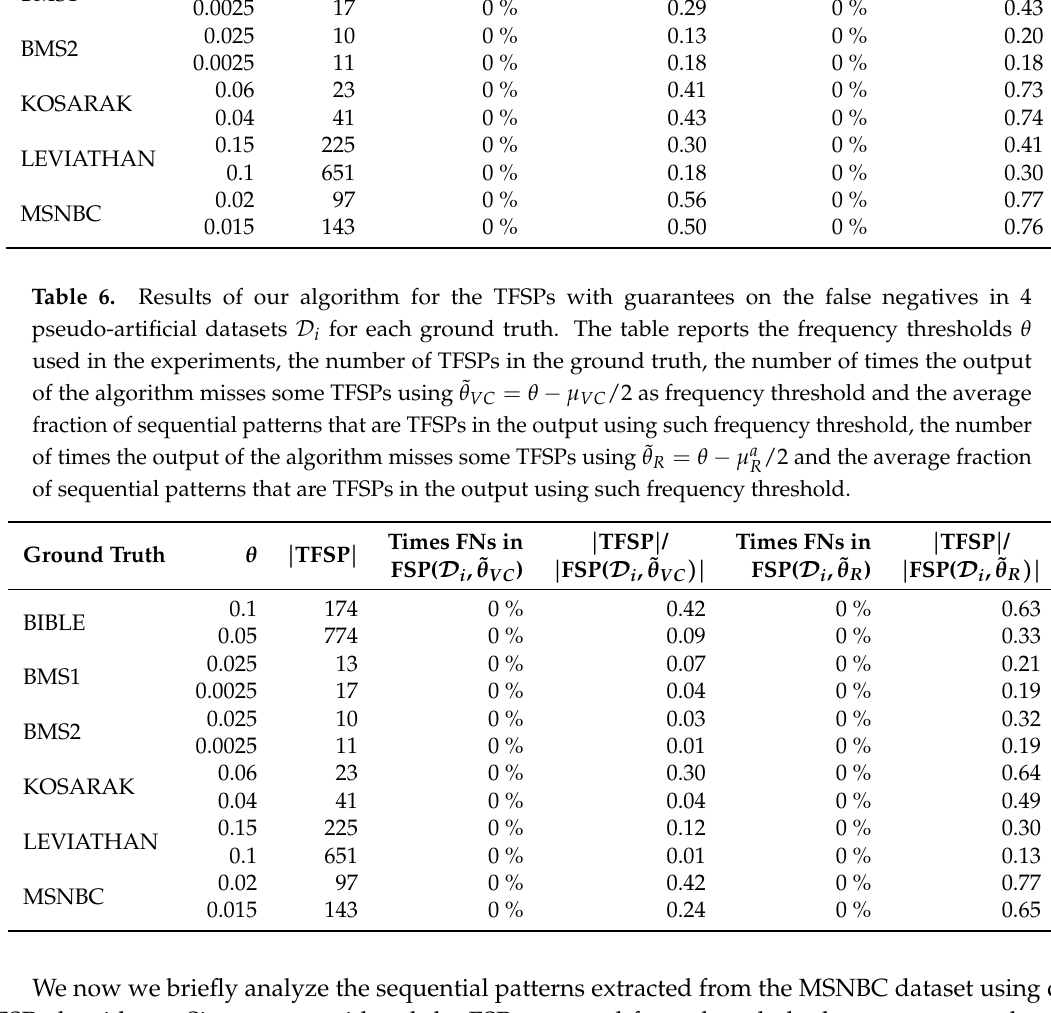
pseudo-artificial datasets we extracted on average ≈ 126 and ≈ 230 sequential patterns with guarantees on the false negatives, using respectively the approximation on the Rademacher complexity and the VC-dimension. With the algorithms with guarantees on the false positives, we mined ≈ 74 and ≈ 54 sequential patterns,